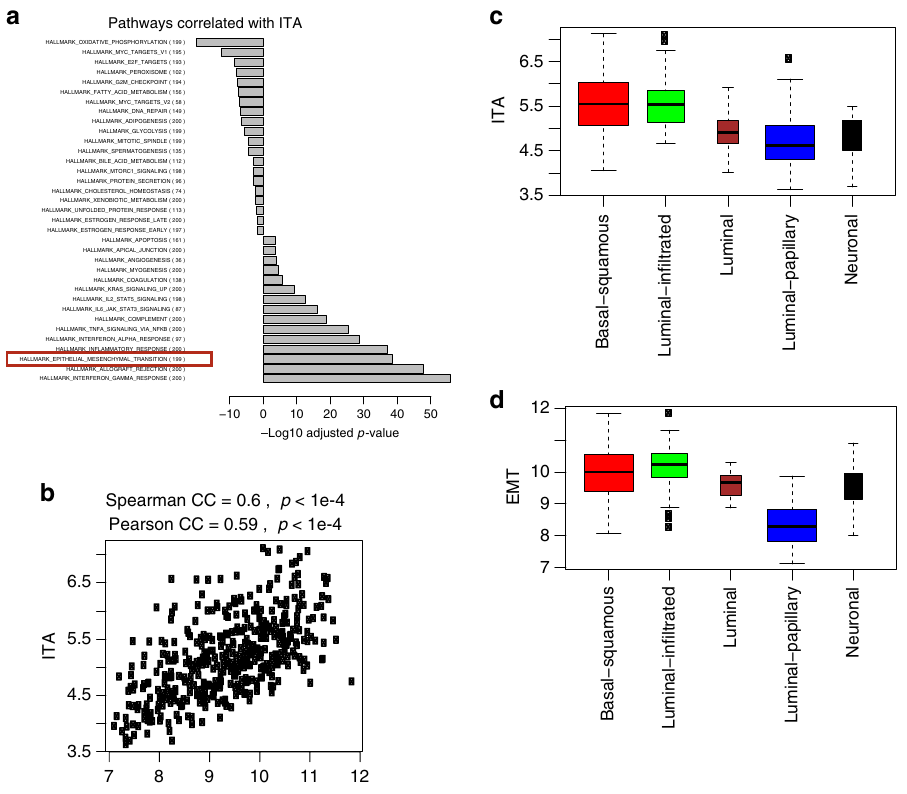
Fig. 2 T-cell related gene expression and EMT-related gene expression are positively correlated in UC specimens. a Pathways ranked by their correlation with ITA. Pearson ’ s correlation coef fi cient (CC) with ITA was calculated for each individual gene in TCGA UC datasets. Wilcoxon rank sum test was then used to compare CC values in each pathway with all the other genes. X -axis shows the – log10 p -value of the Wilcoxon test for each pathway (pathways that were negatively correlated with ITA were given log10 p -value instead); b Plot of the correlation between ITA and EMT in TCGA UC samples; c Plot EMT-related gene expression for different molecular subtypes of UC in TCGA; d Plot EMT-related gene expression for different molecular subtypes of UC in TCGA. For boxplots, boxes extend from the fi rst to third quartiles, middle line shows median, whiskers extend to the most extreme data point which is no more than 1.5 times the interquartile range from the box, open circles show individual values that are more than 1.5 times the interquartile range from the